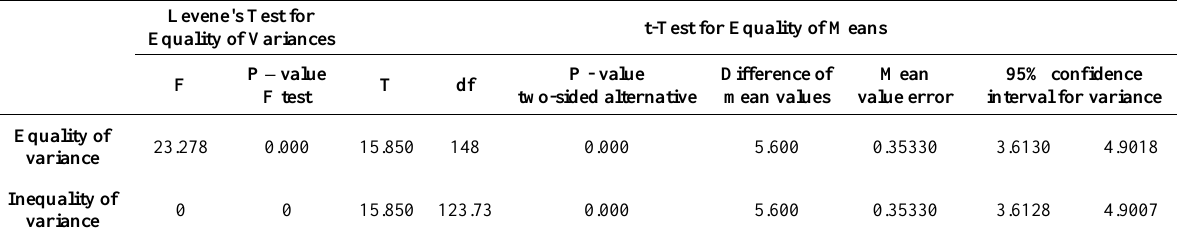
Table 5. Two-sample t-test for hypothesis H2